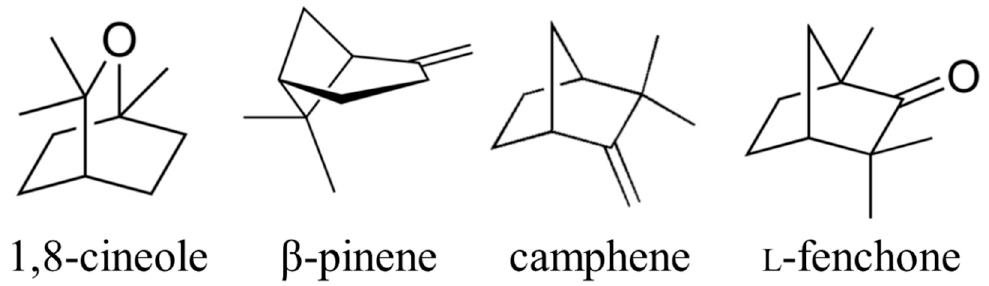
Figure 4. Structure of major volatile compounds from star anise leaves.